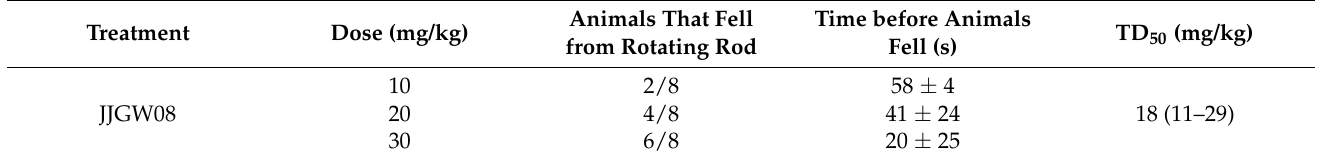
Table 3. The effect of JJGW08 on motor coordination in mice.